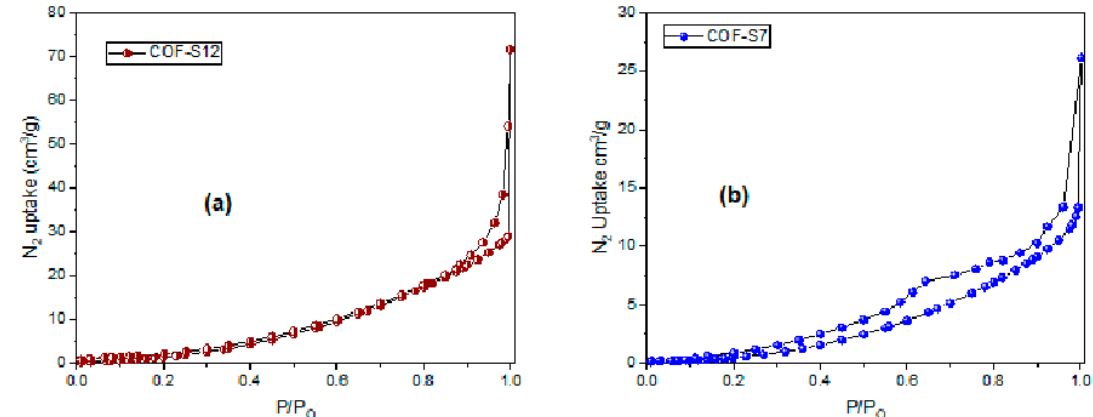
Figure 10. N 2 isotherm of ( a ) COF-S7 and ( b ) COF-S12 at 77 K. The COF-S7 and COF-S12 displayed a BET surface area of 3.44 and 20.73 m 2 g − 1 , respectively (Table 1). Considering this low surface area, adsorption is likely owing to the surface tension that occurs during the activation of the COFs, as the low boiling point solvent utilized is likely to retain robust hydrogen bonding to the vertices of COFs. These diluents will produce sufficient capillary force, resulting in partial or complete disruption of COF scaffolds, or very poor N 2 absorption and negligible surface area, which could be due to pore network obstruction by huge pieces [67,68]. This could be due to the strong polarity and hydrogen capacity of the alcohol group (OH), which makes COF activation challenging. Table 1. Summary of the surface area and pore-opening data of COF-S7 and COF-S12.